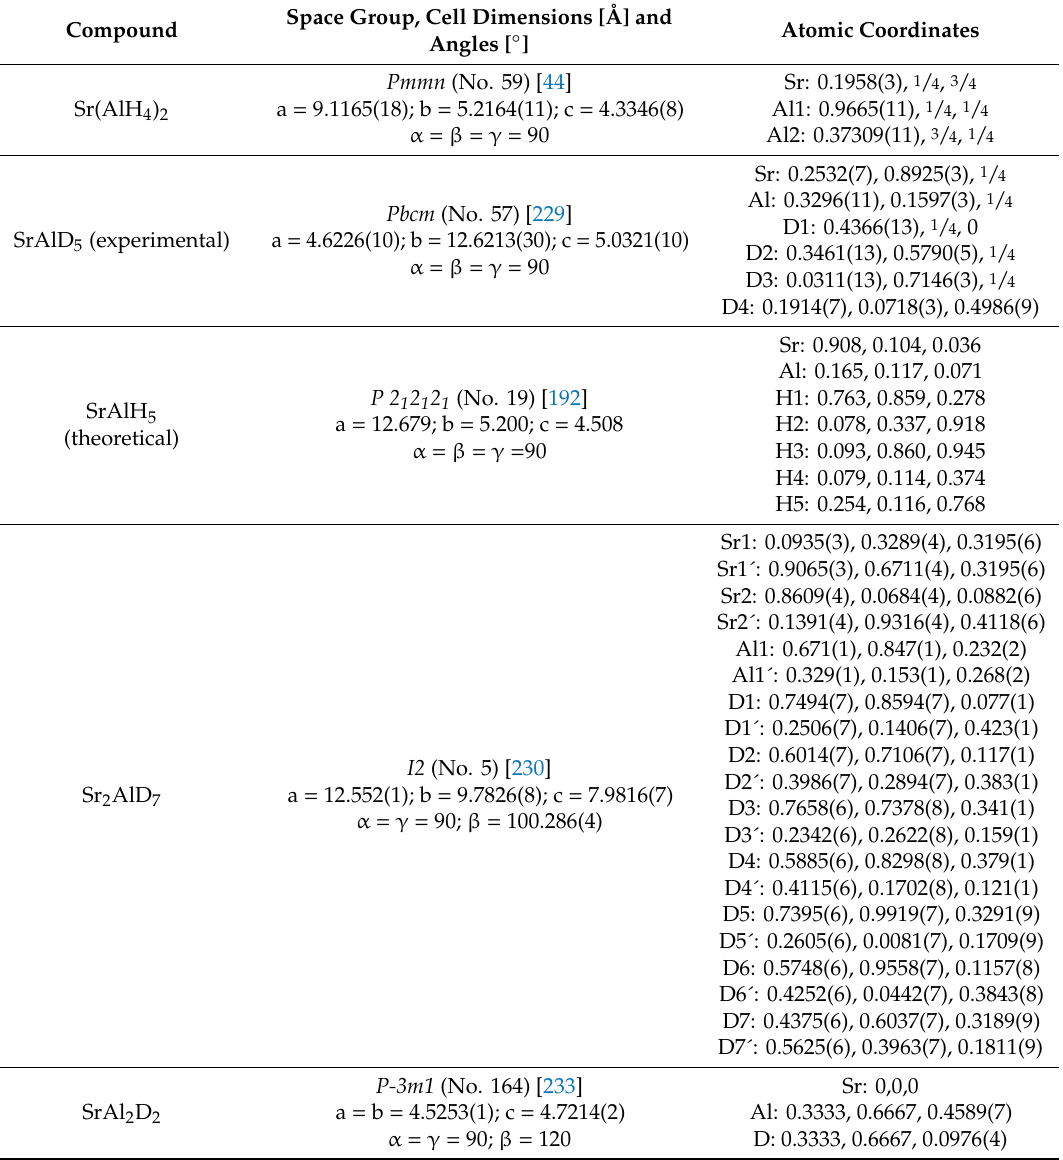
Table 10. Crystallographic data of strontium-aluminum